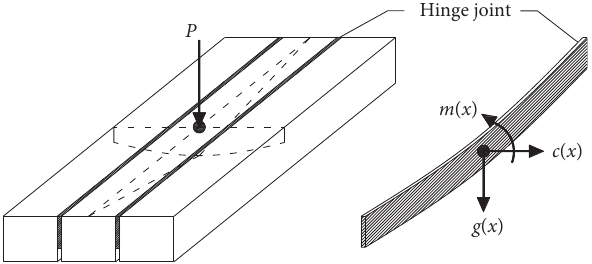
Figure 1: Force diagram of simply supported beam.